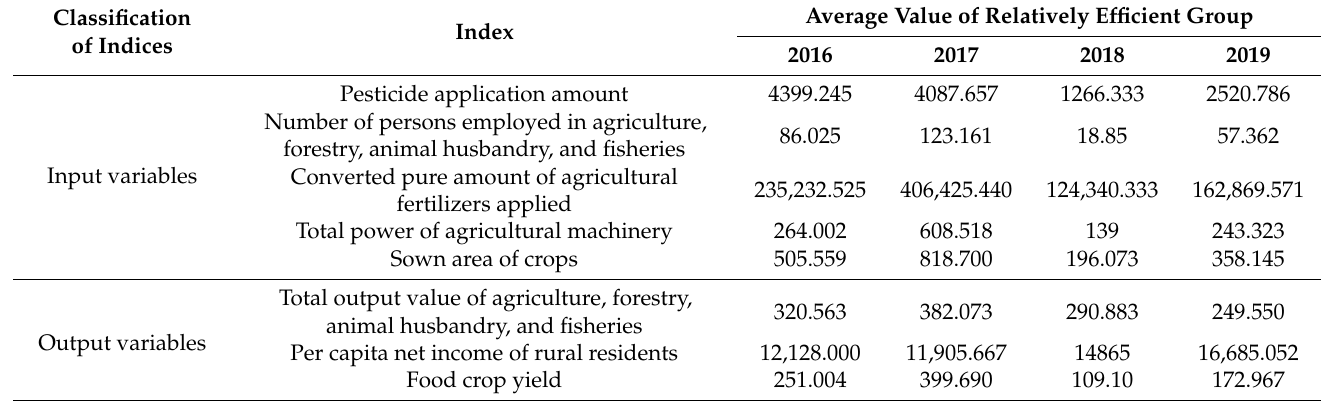
Table 5. Average values of the input–output indices of relatively DEA-efficient cities